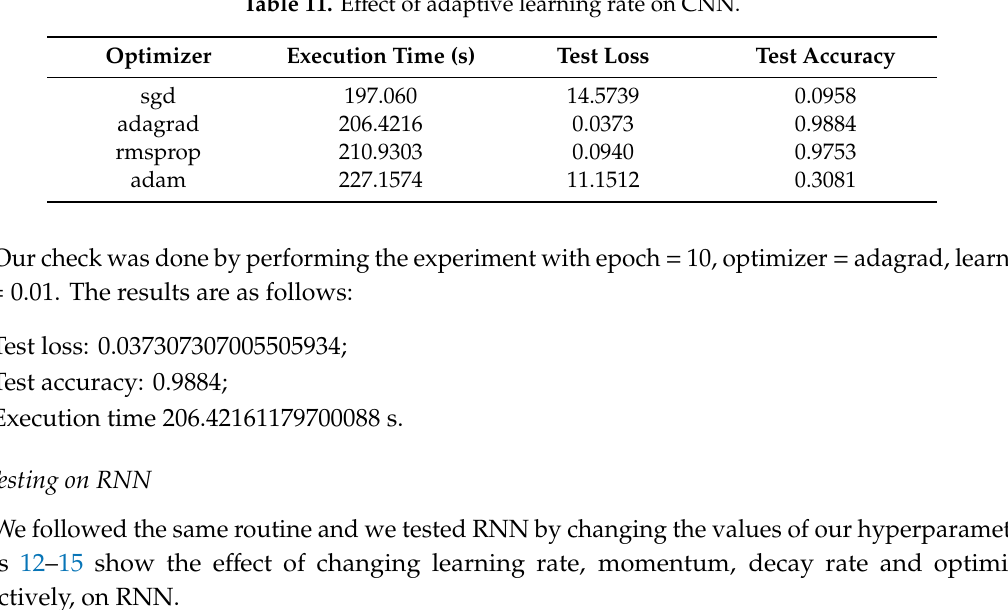
Table 11. E ff ect of adaptive learning rate on CNN.